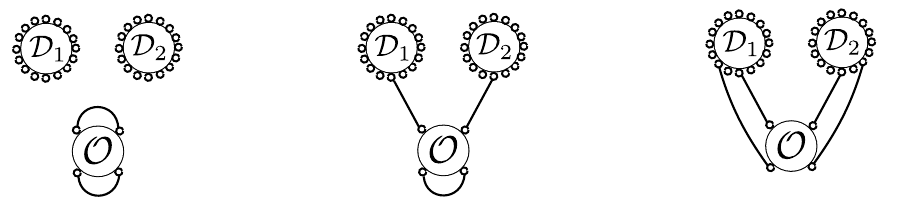
Figure 1 . Feynman diagrams in free theory for G 2 = hD 1 D 2 Oi in (1.4) with O in (2.13). In the effective theory they are generated by the first term (left), second and third term (middle) and last term (right) in (2.14). Dots are the external fields and propagators between determinants are not